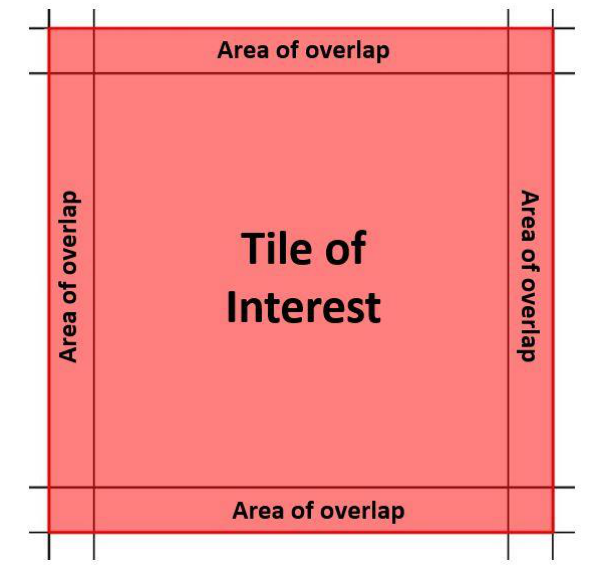
Figure 10: Fused cloud free composite.